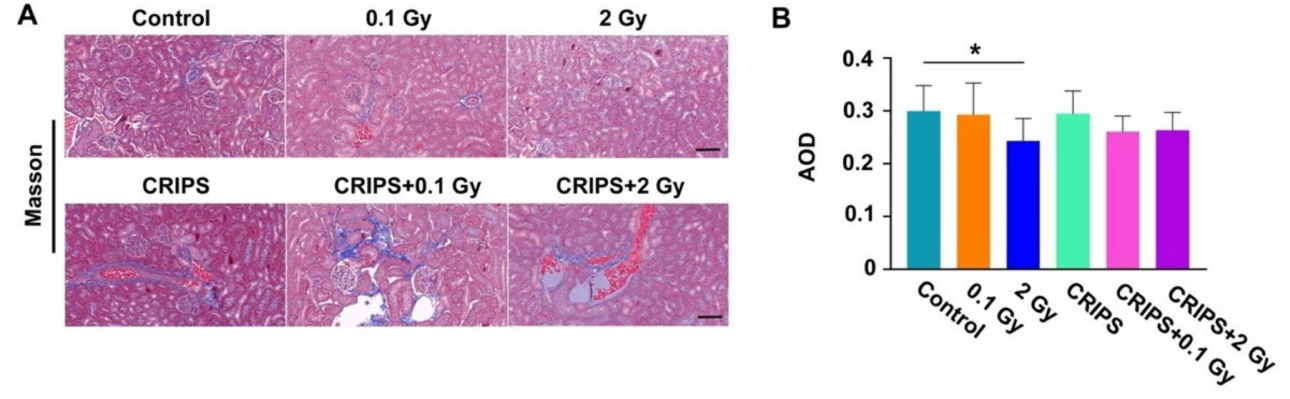
Figure 4. Masson staining of renal sections in Trp53 +/ − mice. ( A ), the blue staining indicates collagen fibers (magnification, 200 × ; scale bar = 100 µ M); ( B ), the average AOD of blue staining in each group. CRIPS, chronic restraint-induced stress; AOD, the average optical density (Integrated optical density/area). * p <